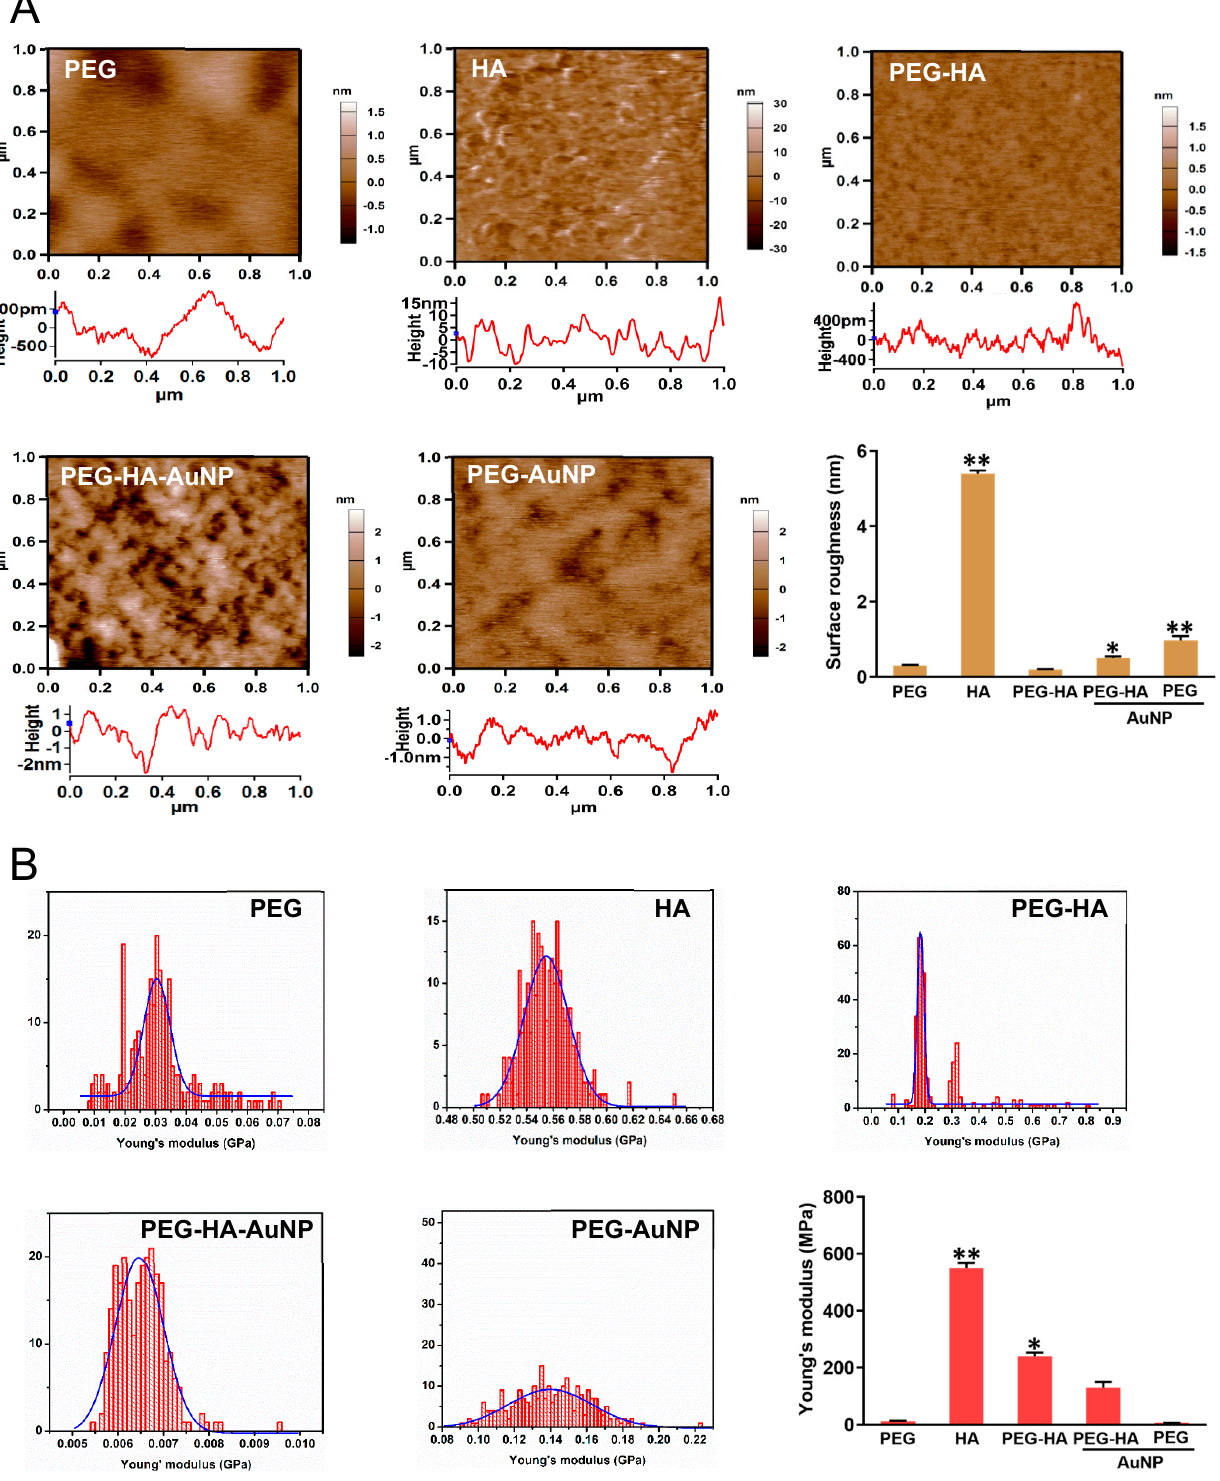
Figure 2. Surface roughness property characterization of different materials by AFM analysis. AFM images of different materials. ( A ) Topographical images of different materials. ( B ) Histograms of Young’s modulus values (MPa) of different materials. The quantification data of surface roughness of AFM, and the quantification of Young’s modulus of different materials. * p < 0.05; ** p < 0.01: smaller than control.